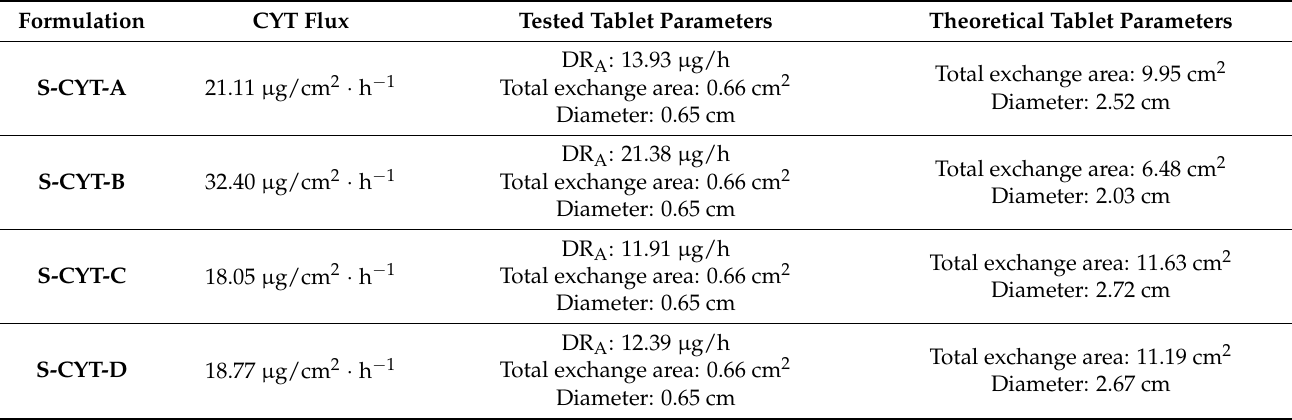
Table 6. Speculative pharmacokinetic considerations: effective surface of tested tablets and calculated surface of tablets to obtain a DR A of 210 µ